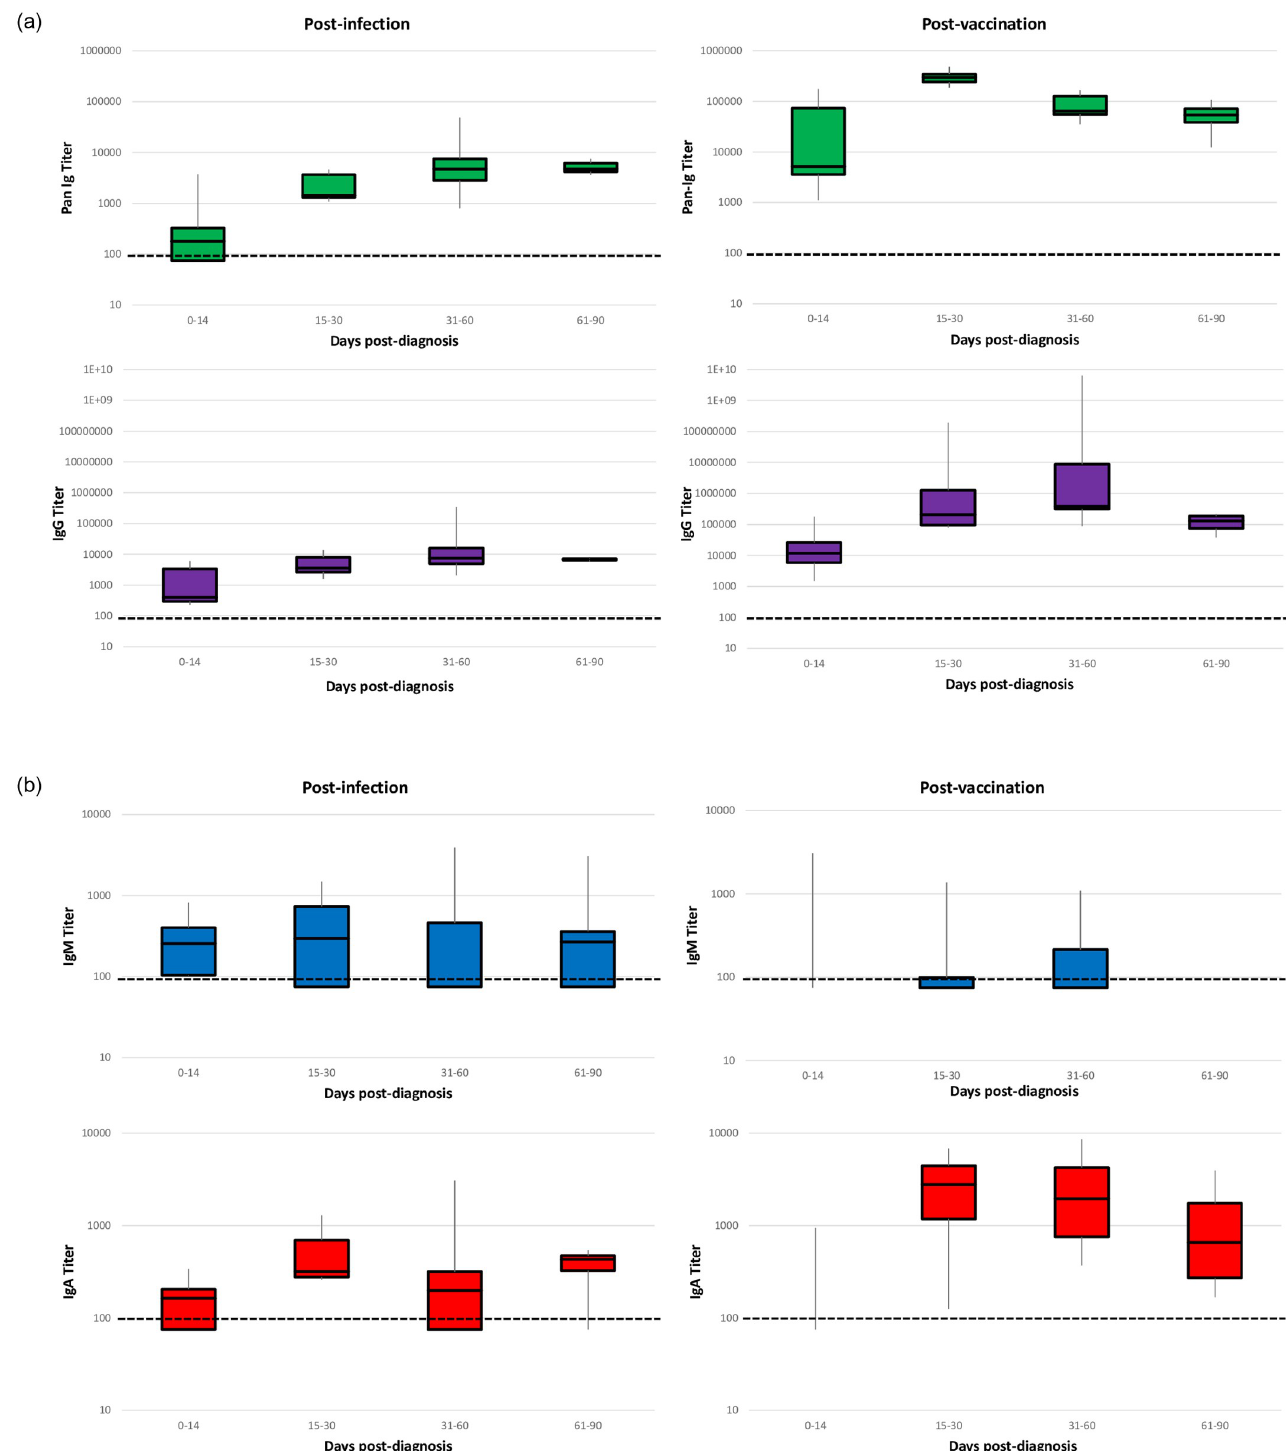
Fig 2. Distribution of anti–SARS-CoV-2 serum antibody titers by isotype and time period among participants (N = 11) in a nursing home cohort— Georgia, October 2020–April 2021. The post-infection period was defined as the time from SARS-CoV-2 diagnosis (by BinaxNOW ™ COVID-19 Ag Cards and/ or real-time reverse transcription polymerase chain reaction) to receipt of first Pfizer-BioNTech COVID-19 Vaccine dose. The post-vaccination period was defined as the time after receipt of first vaccine dose to the end of the evaluation period. Participant G was not included in the post-infection analyses because they did not provide blood specimens during this time period. Participant C was not included in the post-vaccination analyses due to vaccination refusal.